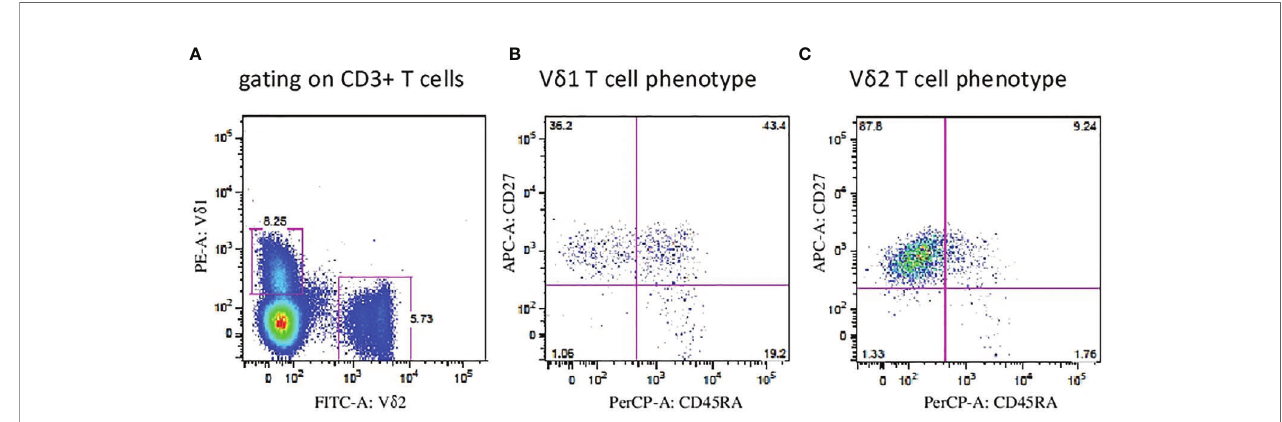
FIGURE 1 | Flow cytometric analysis of V d 1 and V d 2 gd T cells. (A) Peripheral blood mononuclear cells (PBMCs) were analyzed where proportion of V d 1 and V d 2 gd T cells among leukocyte gate followed by the percentage of CD3 lymphocytes. Immunophenotyping of V d 1 (B) and V d 2 (C) T cells using the CD27 and CD45RA antibodies to determine the naïve, memory, effector and TEMRA phenotypes was analyzed and representative fl ow plots are